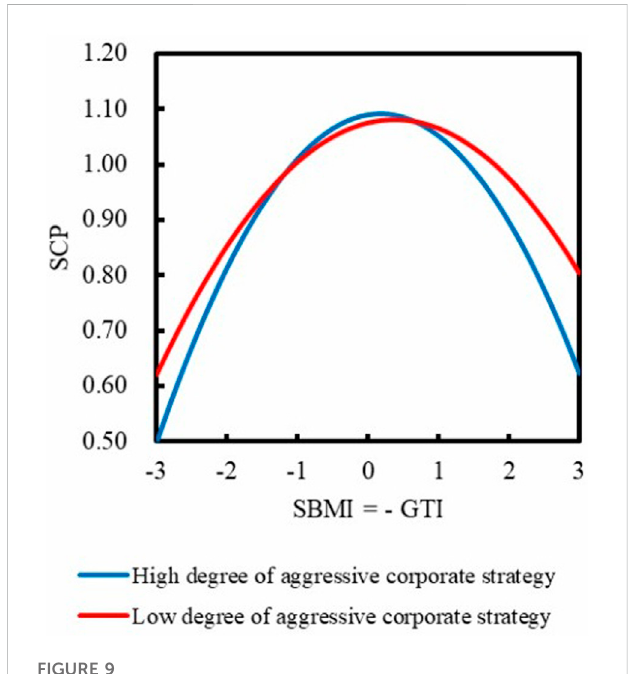
FIGURE 9 Side view of response surface along inconsistency line with the moderating